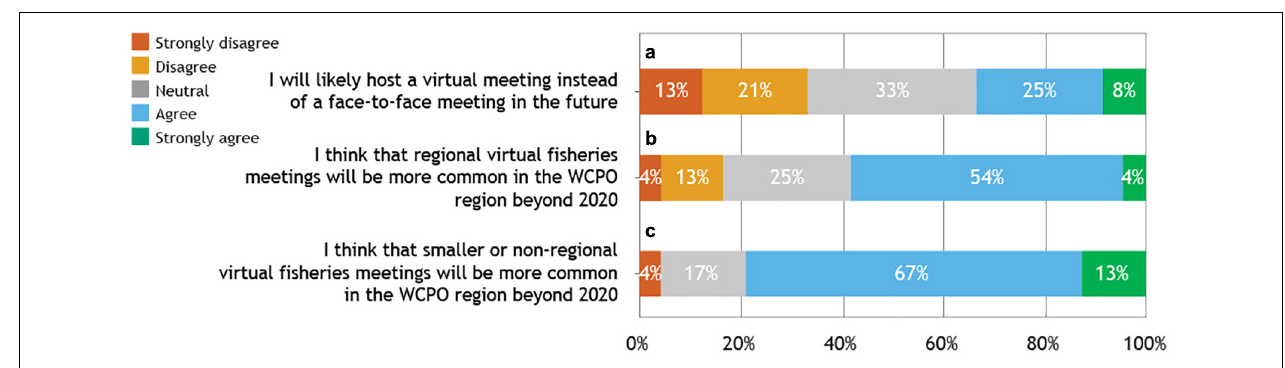
FIGURE 9 | Responses ( n = 24) to What is your level of agreement with the following statements about the